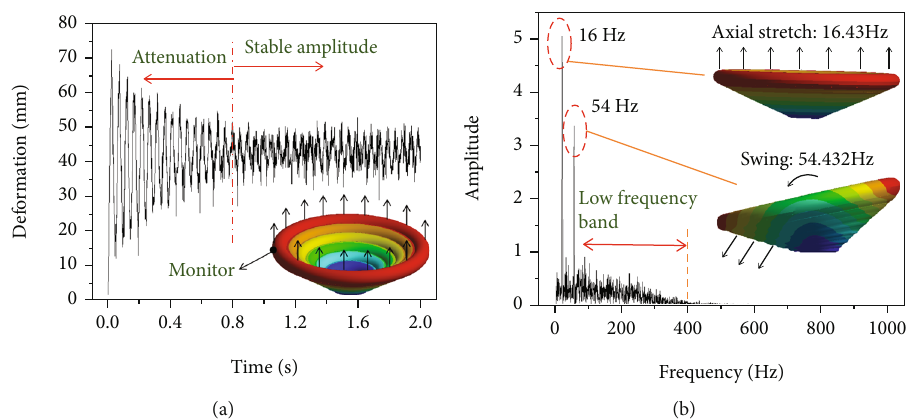
Figure 17: Global vibration and frequency spectrum of toroid: (a) global vibration; (b) frequency spectrum. Time-averaged value (maximum amplitude)